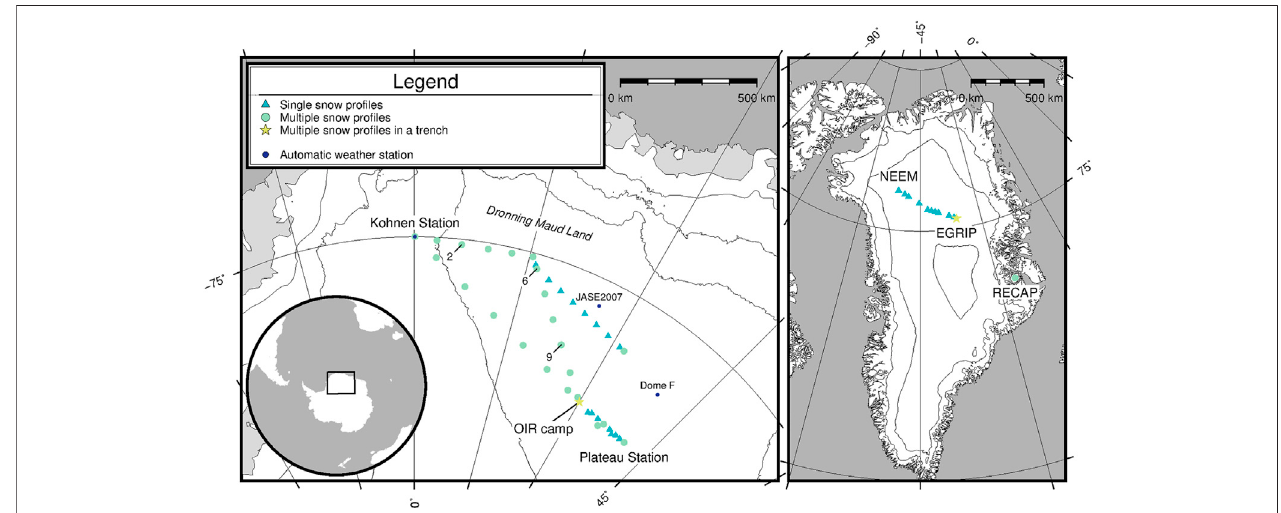
FIGURE1| Overviewmapwiththeinvestigated snowpro fi les.Left:MapofthesamplingsitesalongtheCoFitraverseontheEastAntarcticPlateauin2016/17and at Kohnen Station. Right: Snow pro fi les from various campaigns on the Greenland ice sheet. Locations ofautomatic weather stations in Antarctica are shown with small blue points. The numbers 2, 6, 9 and 14 (Plateau Station) indicate ion pro fi les presented in this manuscript.